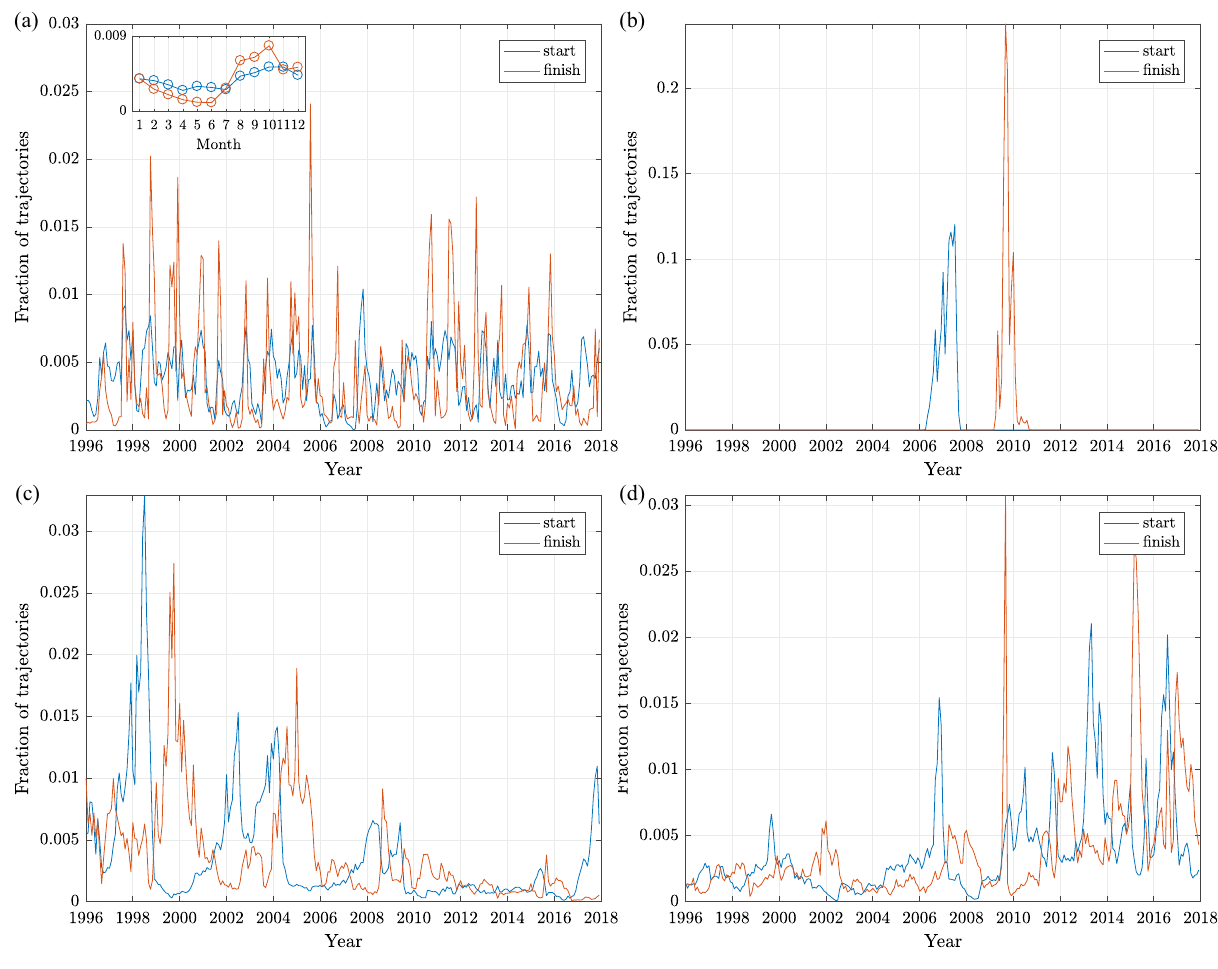
Figure 6. As in Fig. 5, but for transport ALA → SBE ( a ), ALA → GLS ( b ), GLN → CAA ( c ) and CAA → GLN ( d